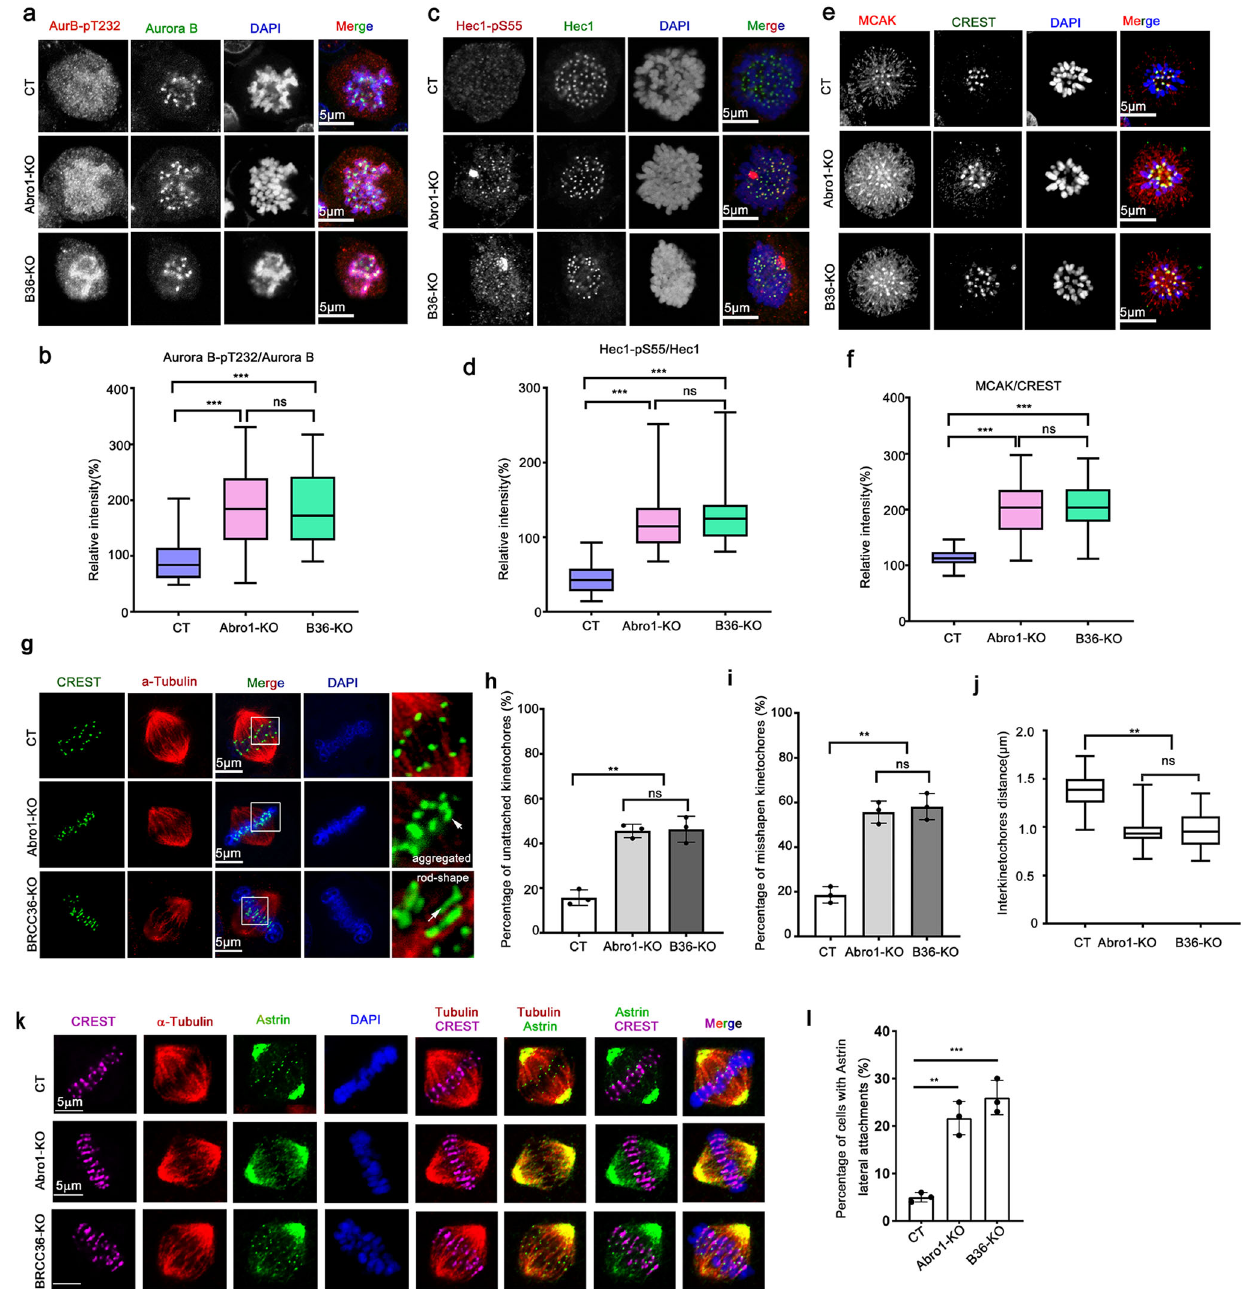
metaphase. We found notable chromosome alignment defects and centromere separation defects in BRCC36/Abro1-KO cells (Supple- mentary Fig. 3c – e), suggesting a defect in correcting improper chromosome – microtubule attachments in KO cells 41 . Moreover, we treated cells with Monastrol, an Eg5 inhibitor, to arrest mitotic cells with monopolar spindles, in which many chromosomes are mal- orientated, K- fi bers attach both sister kinetochores to the same pole (syntelic mal-orientation) 45 . Bipolar spindles and metaphase-aligned chromosomes were formed in control cells after Monastrol removal, while the percentage of misaligned chromosomes was signi fi cantly increased in BRCC36/Abro1-KO cells (Supplementary Fig. 3f,